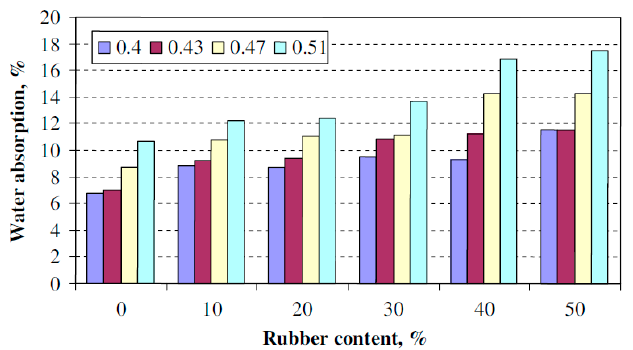
Figure 8. Effect of rubber aggregate content on water absorption of self-consolidating mortar [23]. Reproduced with permission from T. Uyguno ğ lu and I.B. Topçu, The role of scrap rubber particles on the drying shrinkage and mechanical properties of self-consolidating mortars; published by Elsevier, Construction and Building Materials 2010.